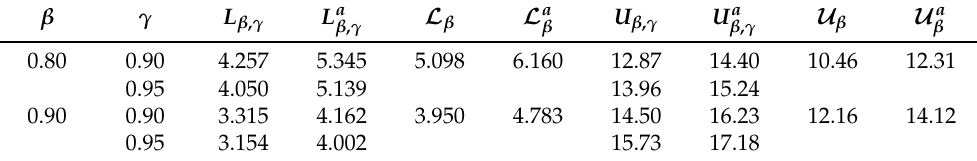
Table 5. Unconditional and conditional lower and upper ( β , γ ) -TLs and β -ETLs in Example 1.